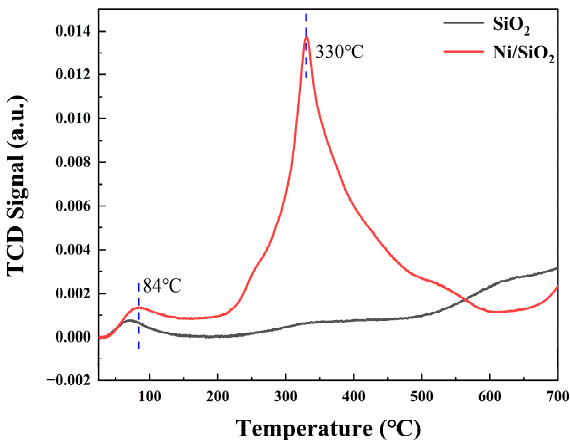
Figure 3. TPD of the SiO 2 support and prepared Ni/SiO 2 .